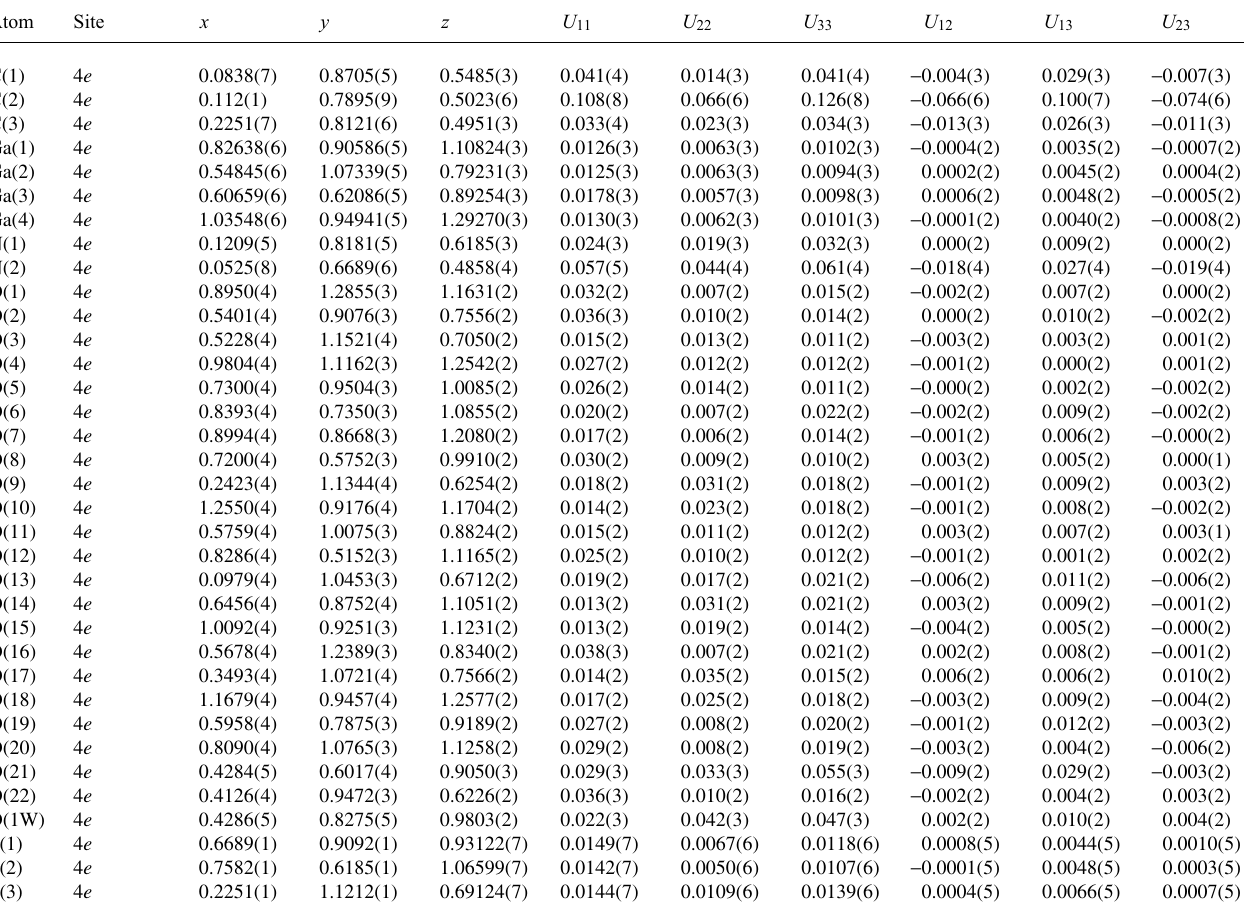
Table 3. Atomic coordinates and displacement parameters (in Å 2 ) .